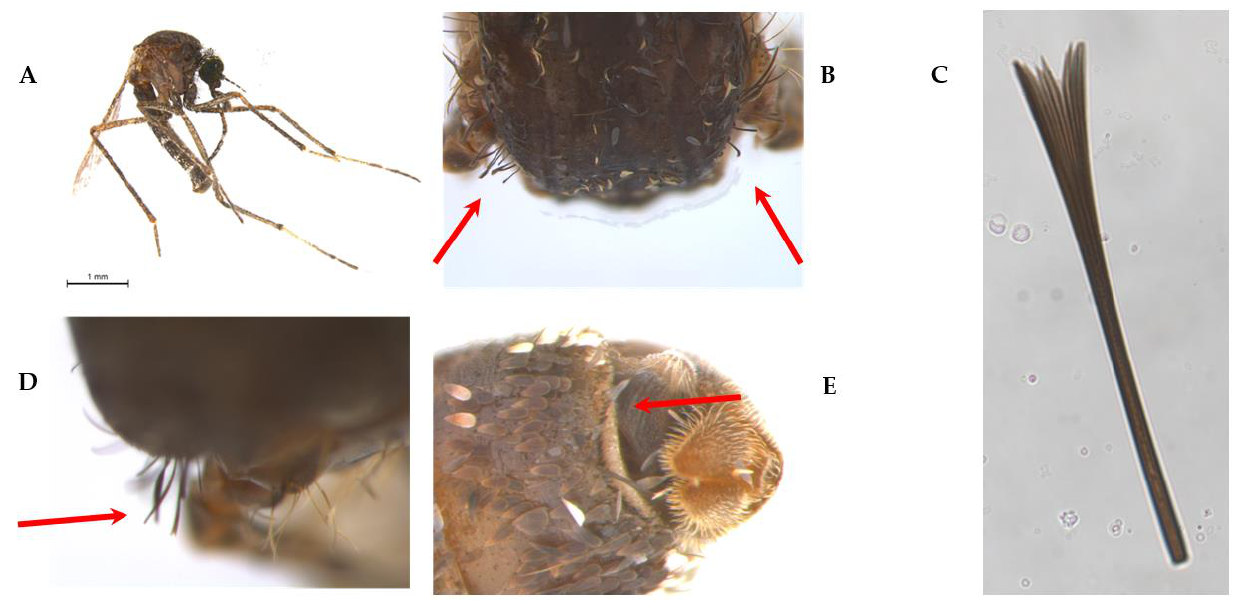
Figure 4. ( A ) Mansonia titillans (ID A290W). ( B – D ) Magnifications showing suprawing scale